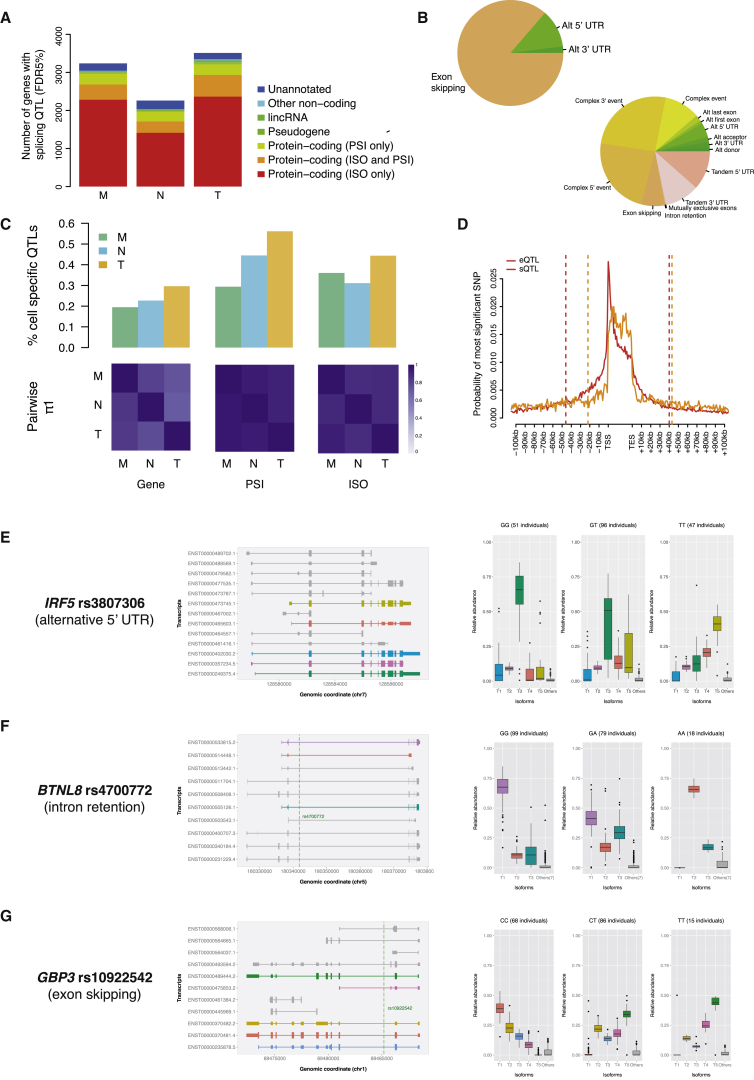
Features, Cell-type Specificity, and Examples of Splicing QTLs(A) Number of protein-coding, non-coding gene, and unannotated events with a significant splicing QTL (FDR <5%).(B) Percentage of different alternative splicing events from PSI (top) and ISO (bottom) analyses.(C) Percentage of PSI and ISO events that are cell-type-specific (top), and genome-wide patterns of QTL sharing (π1 statistics) among the three cell types (bottom).(D) Probability distribution of lead eQTL and sQTL SNPs around genes.(E–G) Examples of alternatively spliced genes showing transcript structure and their distribution based on genotypes at each ISO sQTL. (E) IRF5 and rs3807306, a RA-predisposing SNP that is associated with the switch of two major isoforms that have alternative 5′ UTR in neutrophils. (F) BTNL8 gene structure and rs47007720, which switches a protein-coding major isoform to a non-coding isoform with intron retention in neutrophils. (G) GBP3 gene structure and rs10922542, which switches a protein-coding major isoform to a nonsense-mediated-decay isoform and involves an exon skipping event in T cells.See also Figure S3 and Tables S2, S3, and S4.